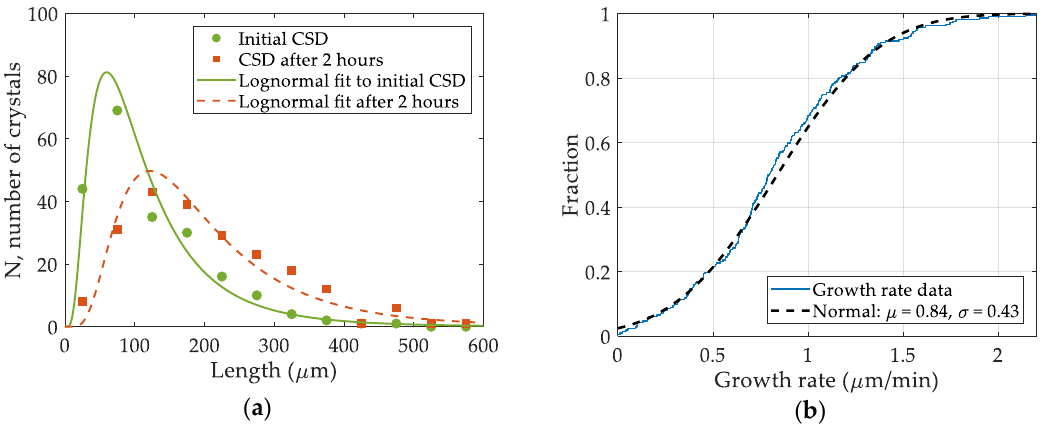
Figure 2. ( a ) The CSD of initial crystals (green circles) and fit to lognormal distribution (solid green curve) and the CSD after 2 h of growth (red squares) and fit to lognormal distribution (dashed red curve) for experiments with an initial loading of 0.03 g, the bin widths are the same for both CSDs. ( b ) Cumulative distribution of growth rates extracted from CSDs for experiments with an initial loading of 0.03 g (solid blue curve) and a normal distribution with a mean of 0.84 and standard deviation of 0.43 μm/min (dashed black curve) for reference. Note that the CSDs are lognormal while the growth rate distribution is normal.